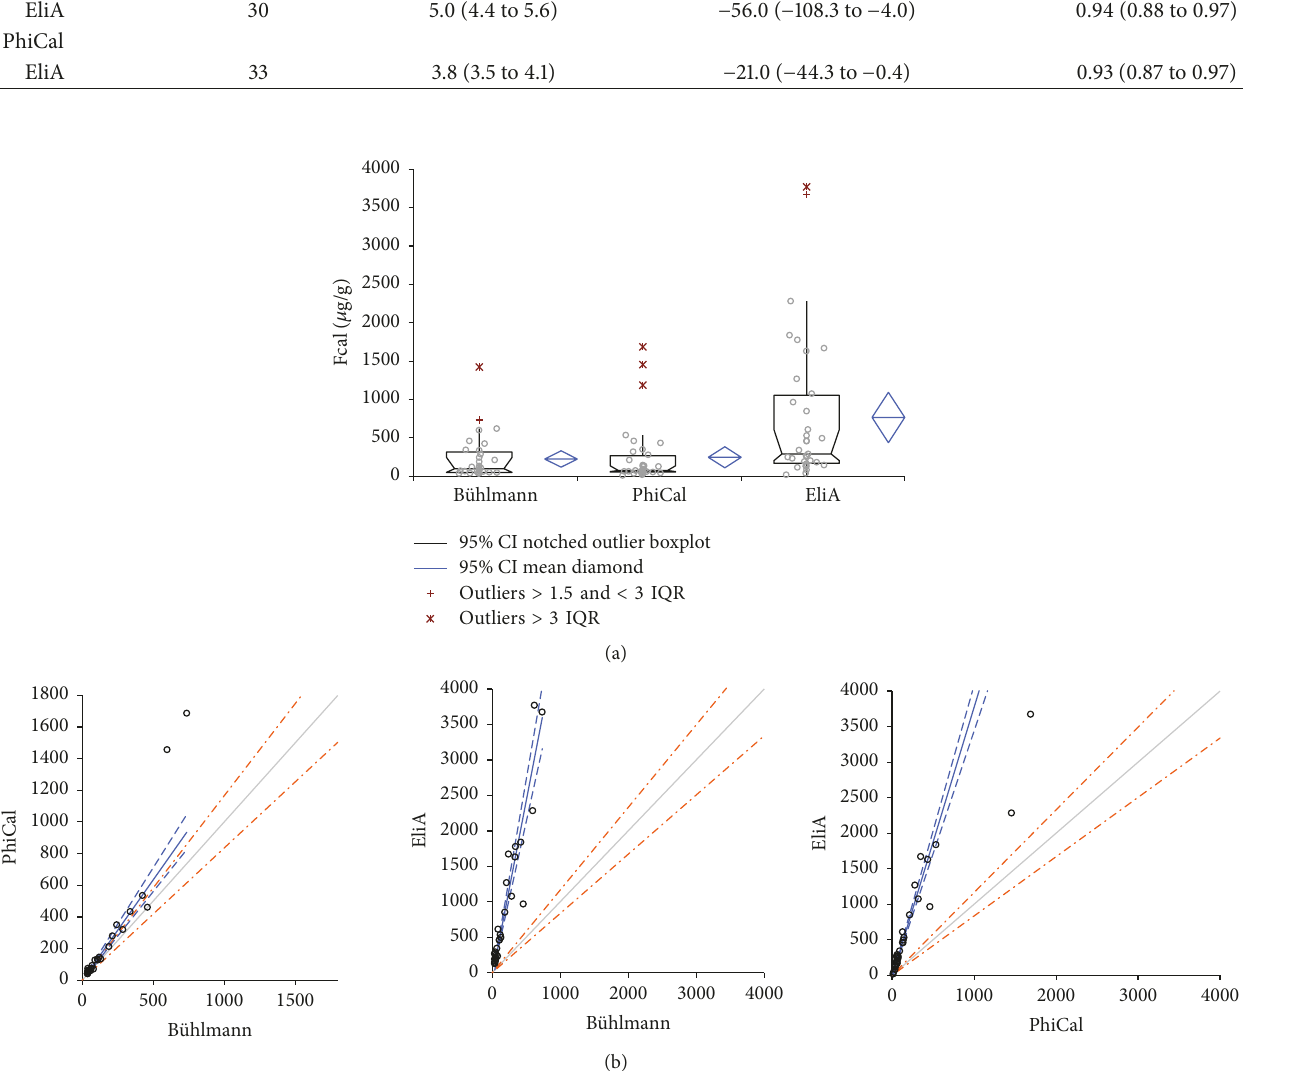
Figure 1: Method comparison between three assays . Direct comparison between the B¨uhlmann Calprotectin ELISA ( 𝑛 = 32 ; mean = 225.2; 95% CI = 119.9–330.4; SE = 51.62; SD = 292.01), PhiCal Calprotectin-EIA ( 𝑛 = 35 ; mean = 247.2; 95% CI = 110.0–384.4; SE = 67.516; SD = 399.432), and Phadia 250 EliA-Calprotectin ( 𝑛 = 35 ; mean = 765.6; 95% CI = 438.3–1092.8; SE = 161.04; SD = 952.70) using (a) descriptive comparative plot and (b) Passing-Bablok regression